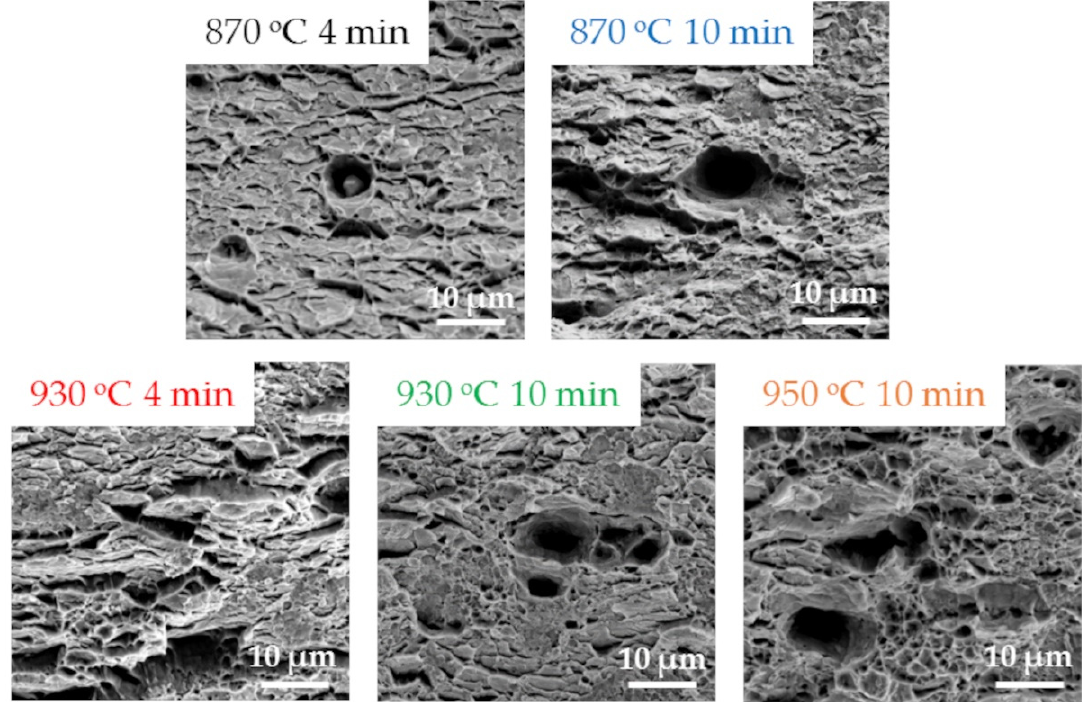
Figure 10. SE-SEM images taken from the center of the fracture surface of the dog-bone specimens of the five heat-treated martensitic steel. The loading direction is into the viewed plane.